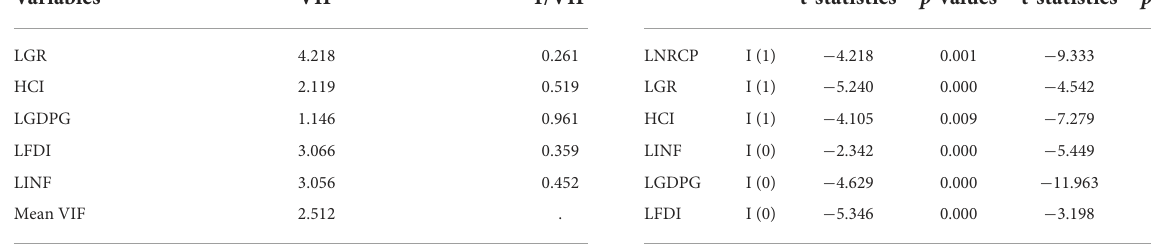
TABLE 5 Unit root